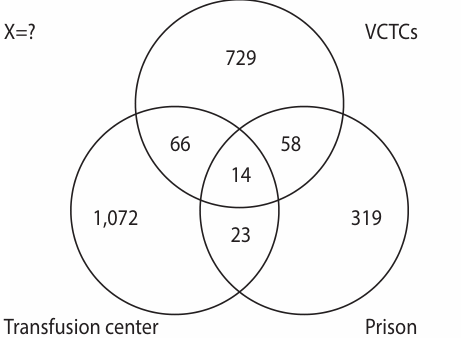
Figure 1. Distribution of the human immunodeficiency virus-positive patients across 3 data sour ces: transfusion center, volunteer coun- seling and testing centers (VCTCs), and prison. X,